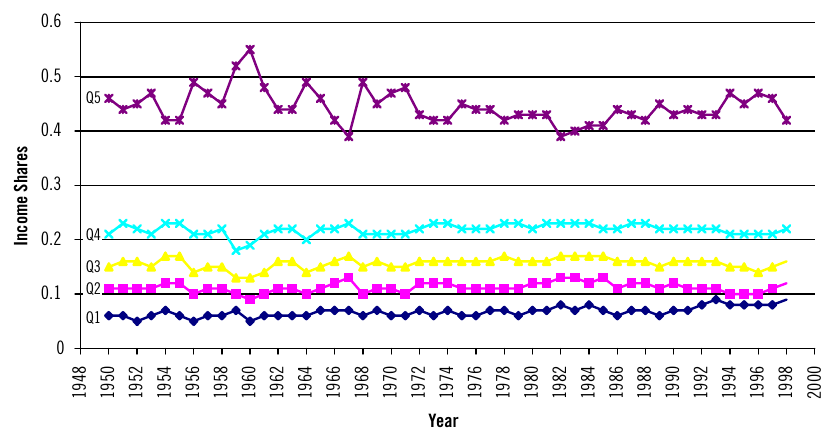
Figure 2 – Development of Global Income